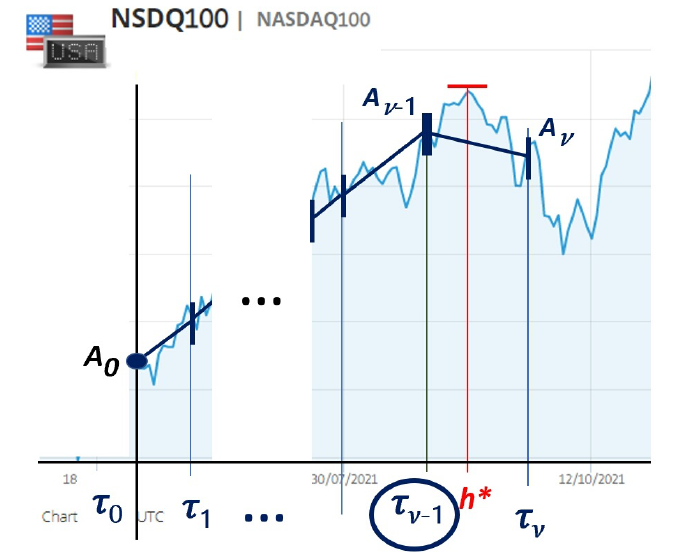
Figure 2. SBFP on NASDAQ 100 stock chart for 6 months ( Source: etoro.com